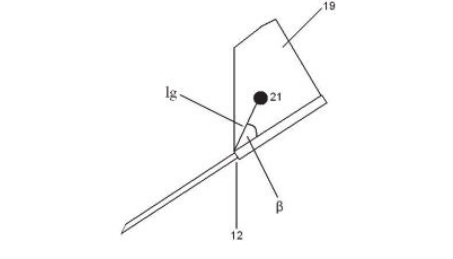
Figure 7A: A new type of peripheral venous access needle in- corporating a guider component 20 for needle motion control.